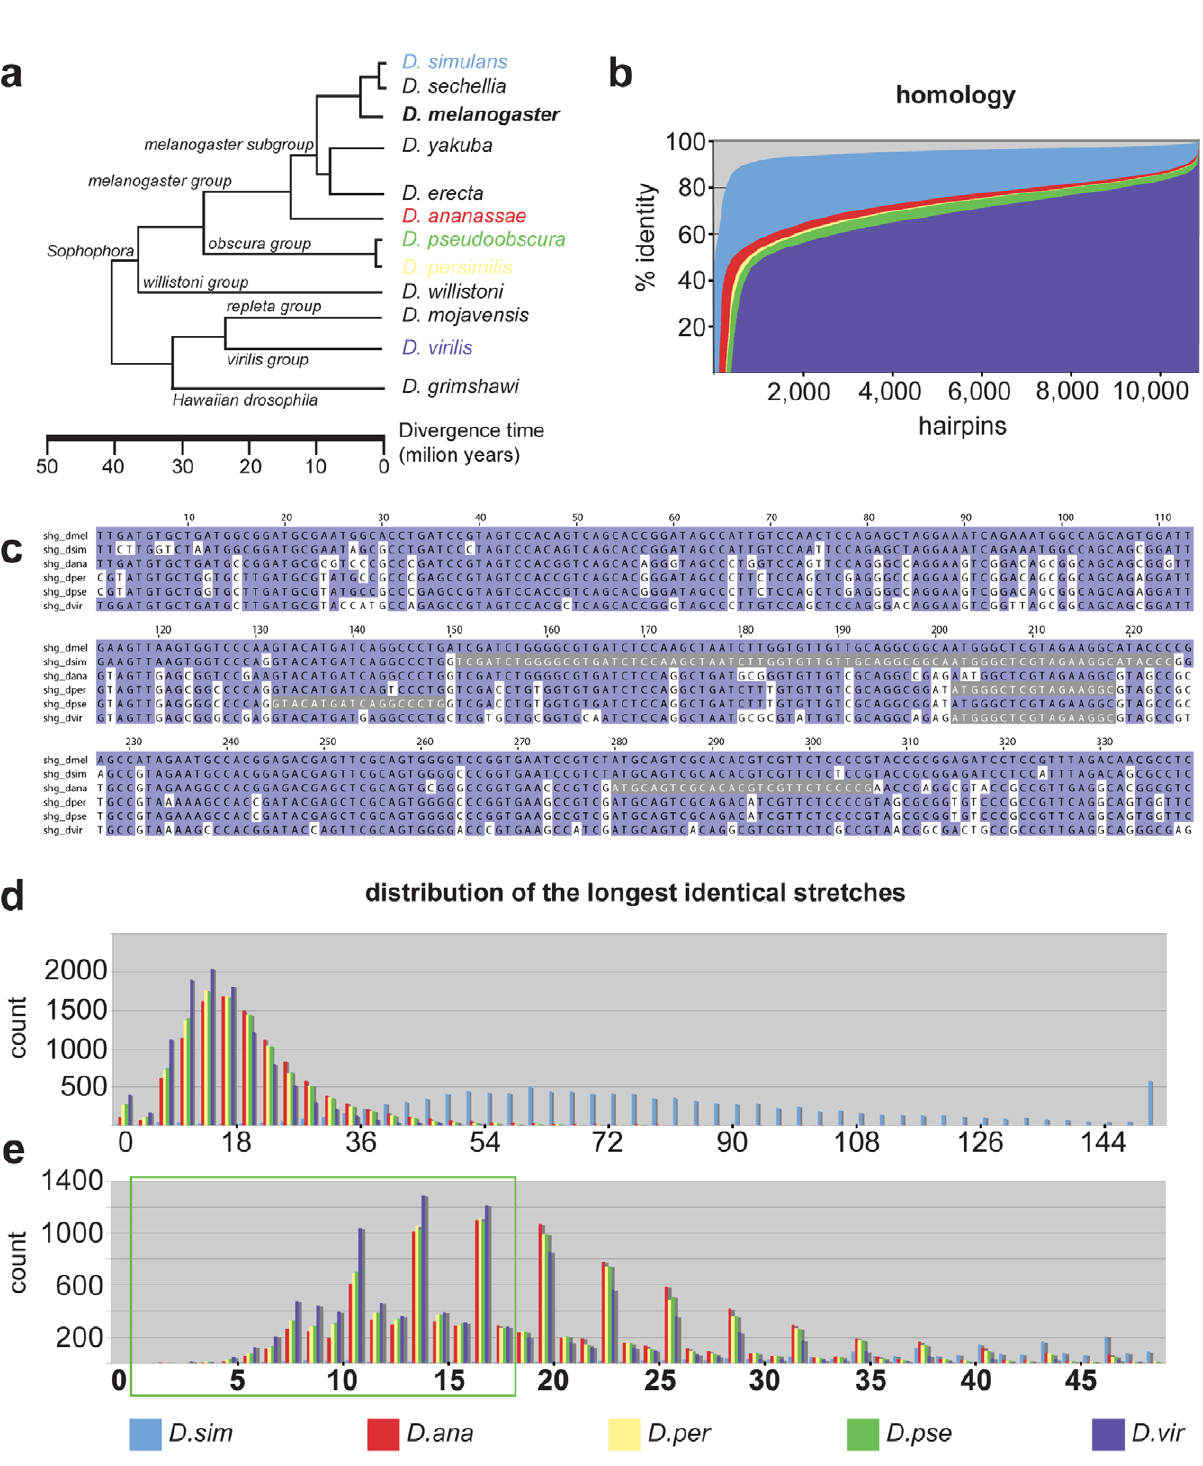
Figure 1. Comparative analysis of hairpin sequence divergence. ( a ) Phylogeny of sequenced Drosophila species. D. melanogaster is a standard model system in which transgenic RNAi is a well established technique. Species selected for comparative analysis are colour-coded. ( b ) Summary of the conservation of RNAi hairpins in pair-wise genome alignments with D. melanogaster as common reference. The percentage of nucleotides identical across the hairpin alignment (y-axis) is plotted for all hairpins ordered by increasing conservation (x-axis). Species are colour- coded according to ( a ). ( c ) An example of 6 species multiple sequence alignment for a hairpin targeting shotgun (shg) . Nucleotides identical to D. melanogaster are shaded in magenta. The longest uninterrupted stretch of identical nucleotides is shaded grey for each species. ( d ) Histogram of longest uninterrupted stretches for all hairpins binned in size groups of 3. ( e ) A portion of the histogram in ( d ) re-binned to bin size of 1 and limited to the maximum 50 nucleotide stretch. The periodic peaks are the consequence of the fact that most hairpins cover coding regions and reflect the increased likelihood of stretch interruption at the highly divergent third nucleotide of a codon triplet. The portion of the distribution that contains hairpins likely refractory to RNAi is highlighted by the green rectangle. The species are colour-coded as in ( a ).